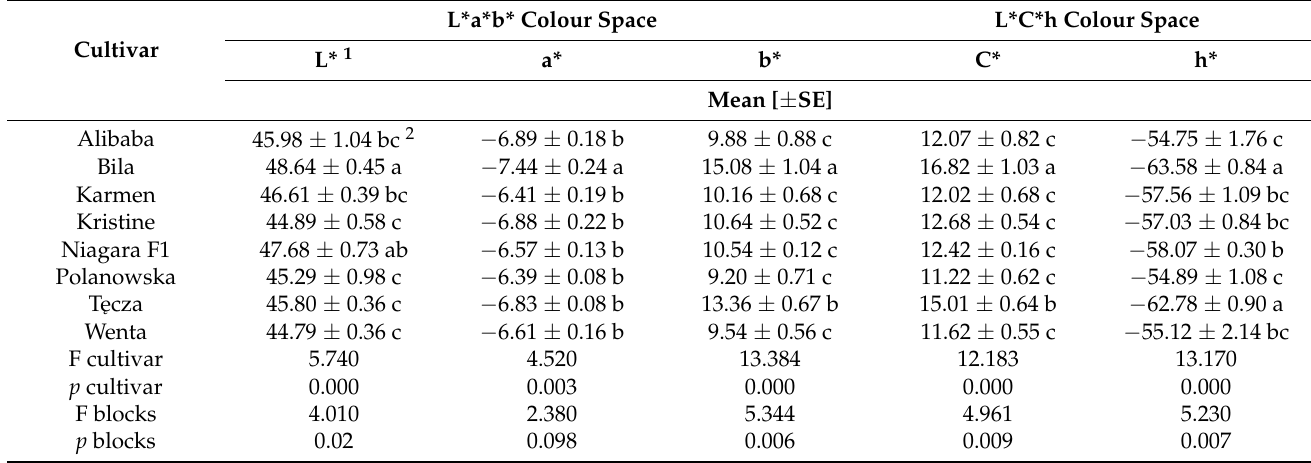
Table 1. Colorimetric characteristics of onion leaves in 2015.